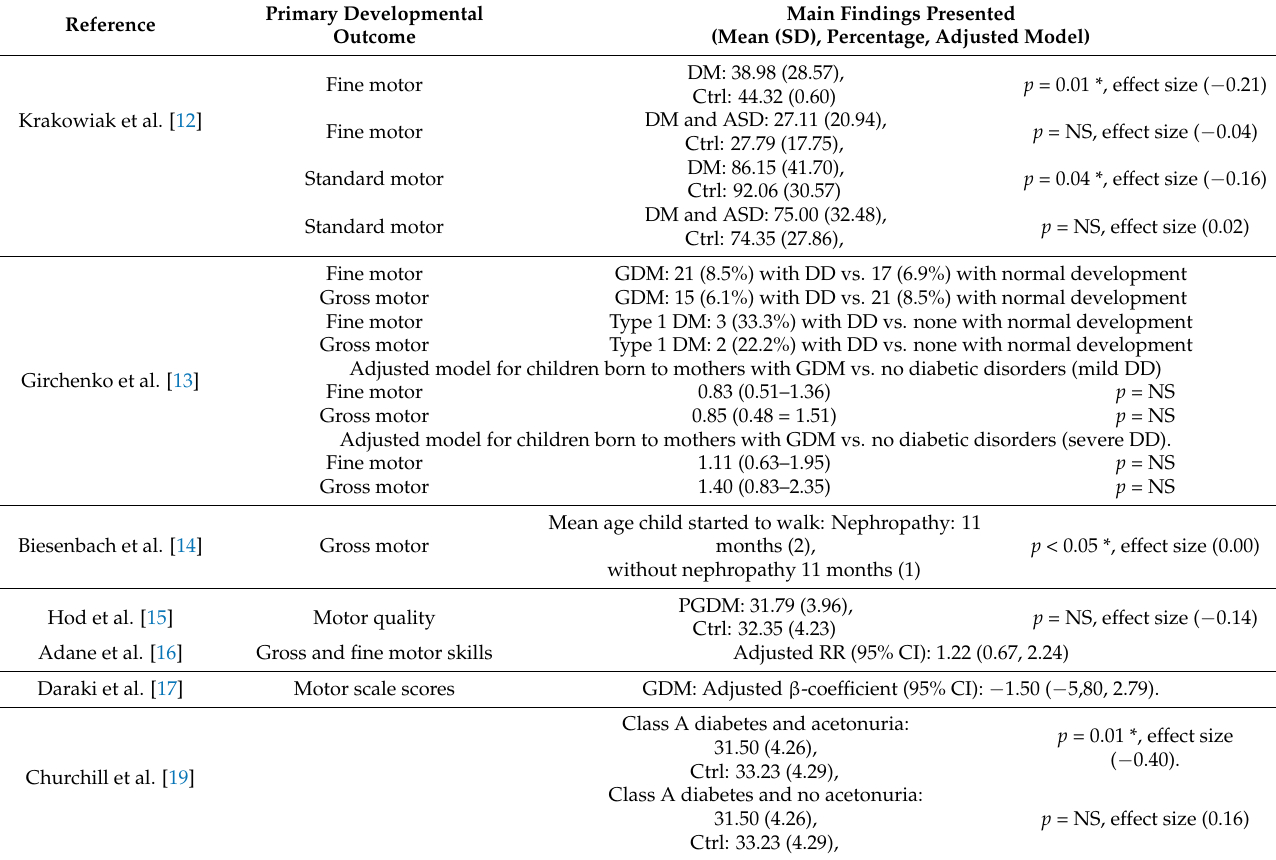
Table 3. Summary of studies on motor development included in this